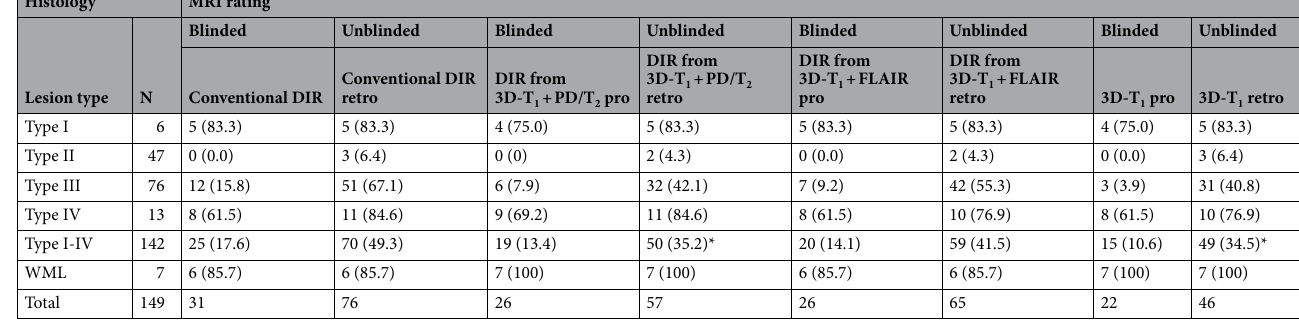
Table 2. Lesion count (sensitivity in %) MRI scoring. N = number of detected/discernible cortical lesions; WML = white matter lesion. *Significant differences (i.e. P < 0.05) compared to conventional